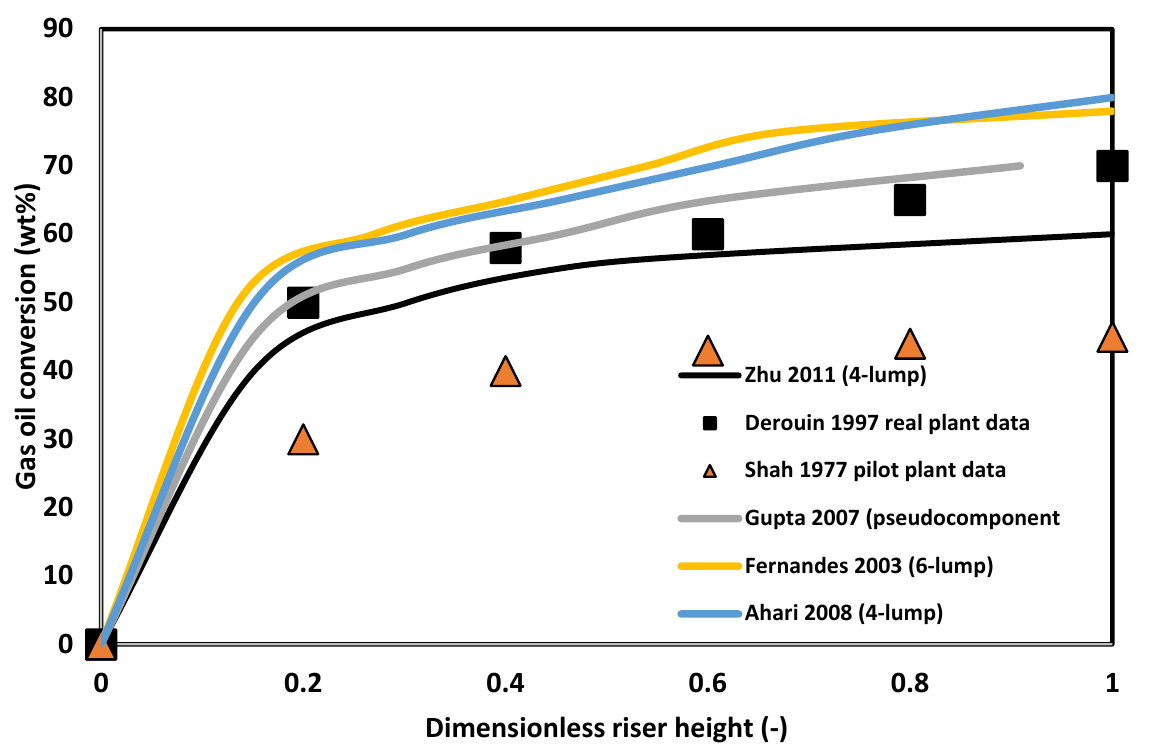
Figure 9. Comparison of gas oil conversion predicted profiles of FCC riser with measured data of Shah 1977 [224] and Derouin 1997 [153].